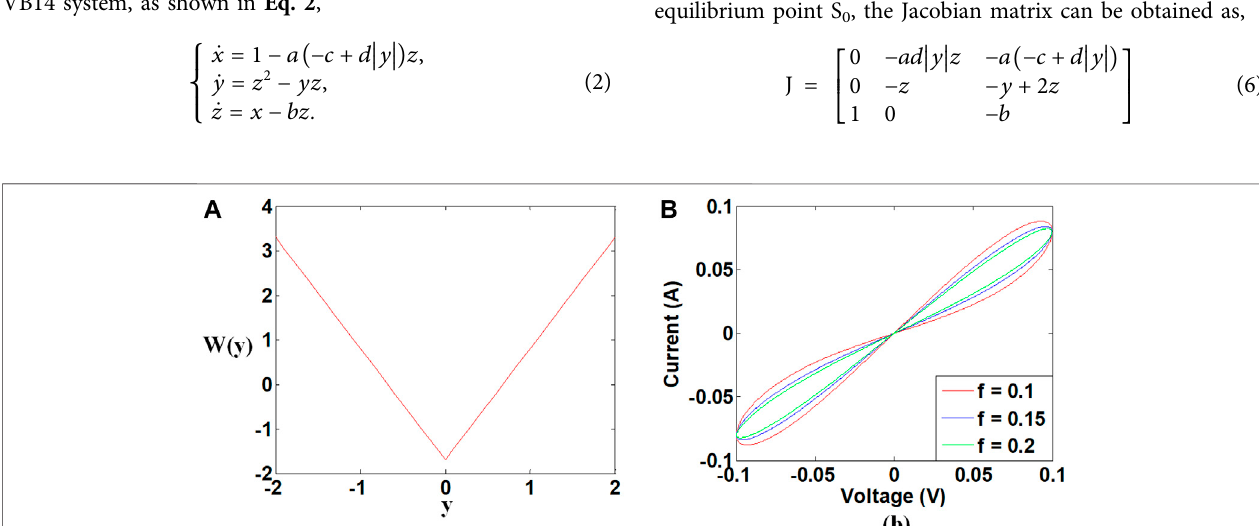
FIGURE 2 | Memristor function and corresponding hysteresis loop. (A) memristor function, (B) hysteresis loop.